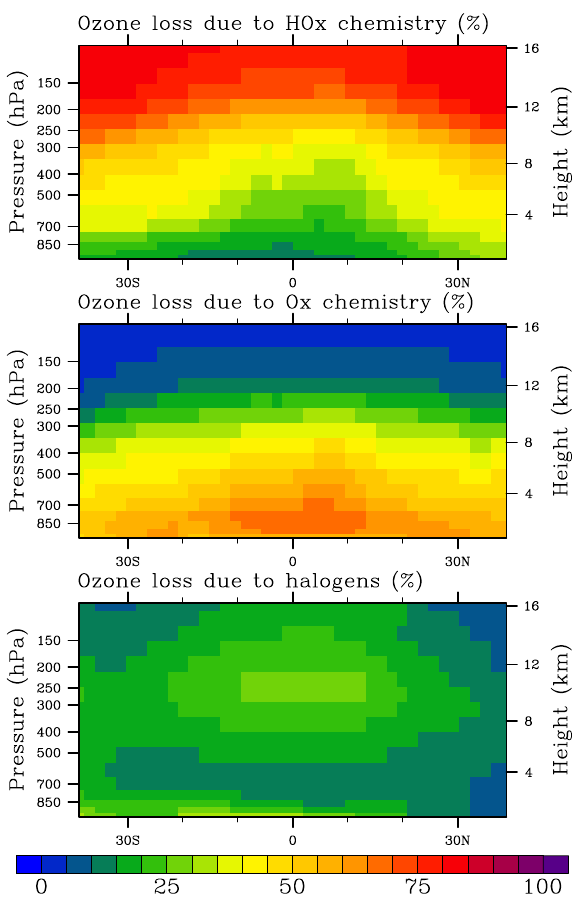
Fig. 6. Percentage of the annually integrated chemical ozone loss from HO x , O x and halogen photochemistry as simulated by CAM- Chem.